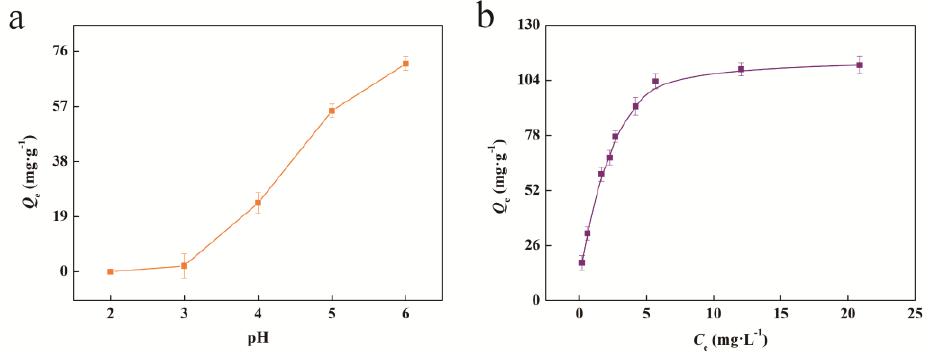
Figure 3. ( a ) Influence of pH values on adsorption capacity; ( b ) The adsorption kinetic curves of sandwich adsorptive membrane for Cu 2+ .